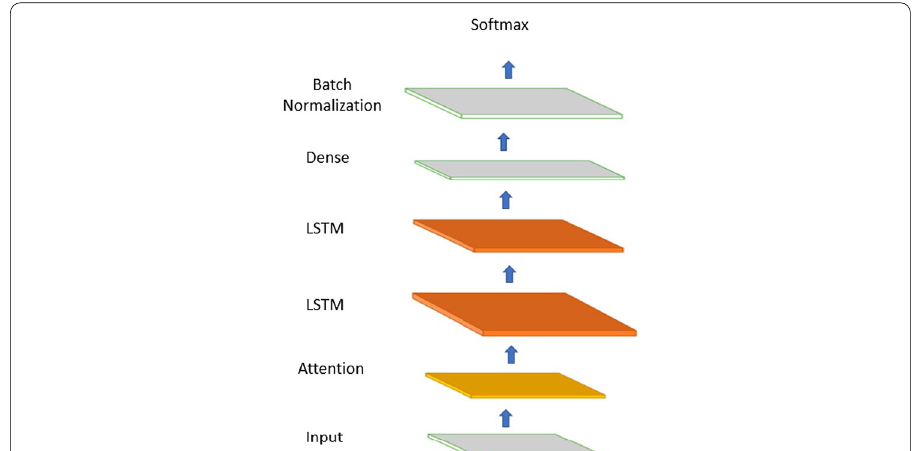
Fig. 9 Long Short Term Memory network architecture with attention layer